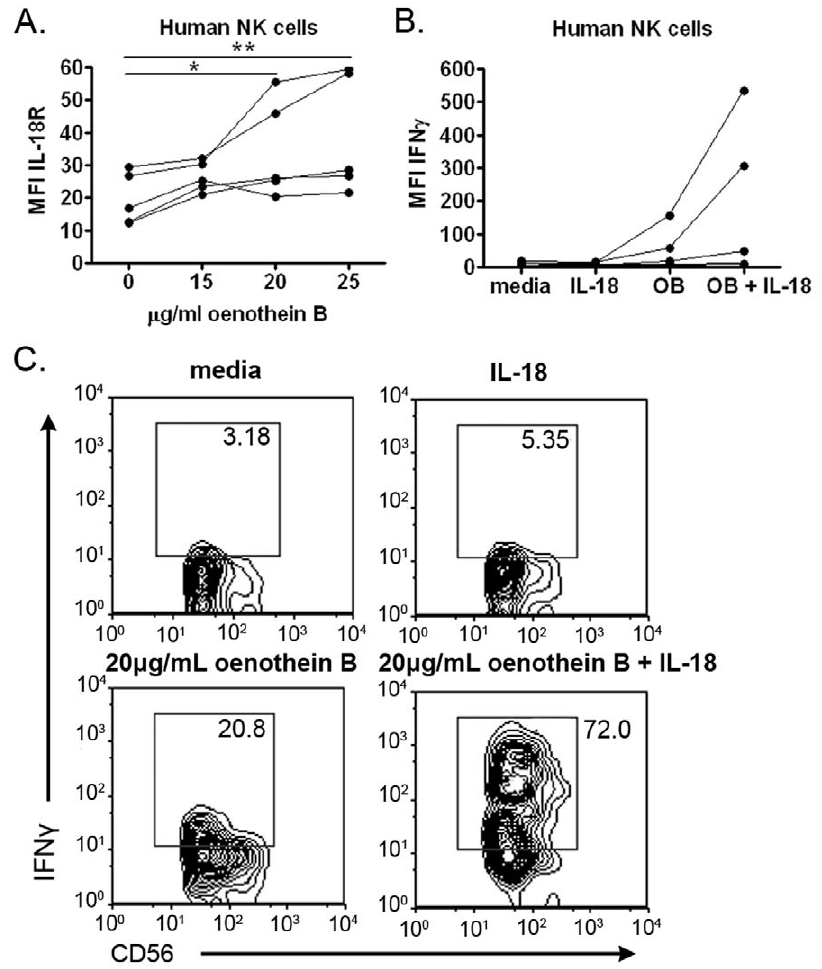
Figure 6. Priming of human NK cells to IL-18 by oenothein B. (A) Human PBMCs (10 5 cells/well) were treated with the indicated concentrations of oenothein B or X-VIVO medium alone for 48 hrs, and expression of IL-18R on human NK cells was determined by flow cytometry. Significance was determined by One-way ANOVA with Bonferroni post-test. *p , 0.05, **p , 0.01 (B) Human PBMCs (10 5 cells/well) were treated with 20 m g/ml oenothein B or X-VIVO medium alone for 48 hrs. Cells were washed with PBS and treated with 50 ng/ml rhu IL-18 for 6 hrs in the presence of brefeldin A. IFN c staining [mean fluorescent intensity (MFI)] on human NK cells was determined by flow cytometry. The graphs represent data from five individuals, with each treatment analyzed in triplicate. (C) Representative examples of two-color flow cytometry plots comparing IFN c staining on gated human NK cells treated with 20 m g/ml oenothein B, 50 ng/ml rhuIL-18, both, or X-VIVO medium alone. *p , 0.05, **p , 0.01, ***p , 0.001.